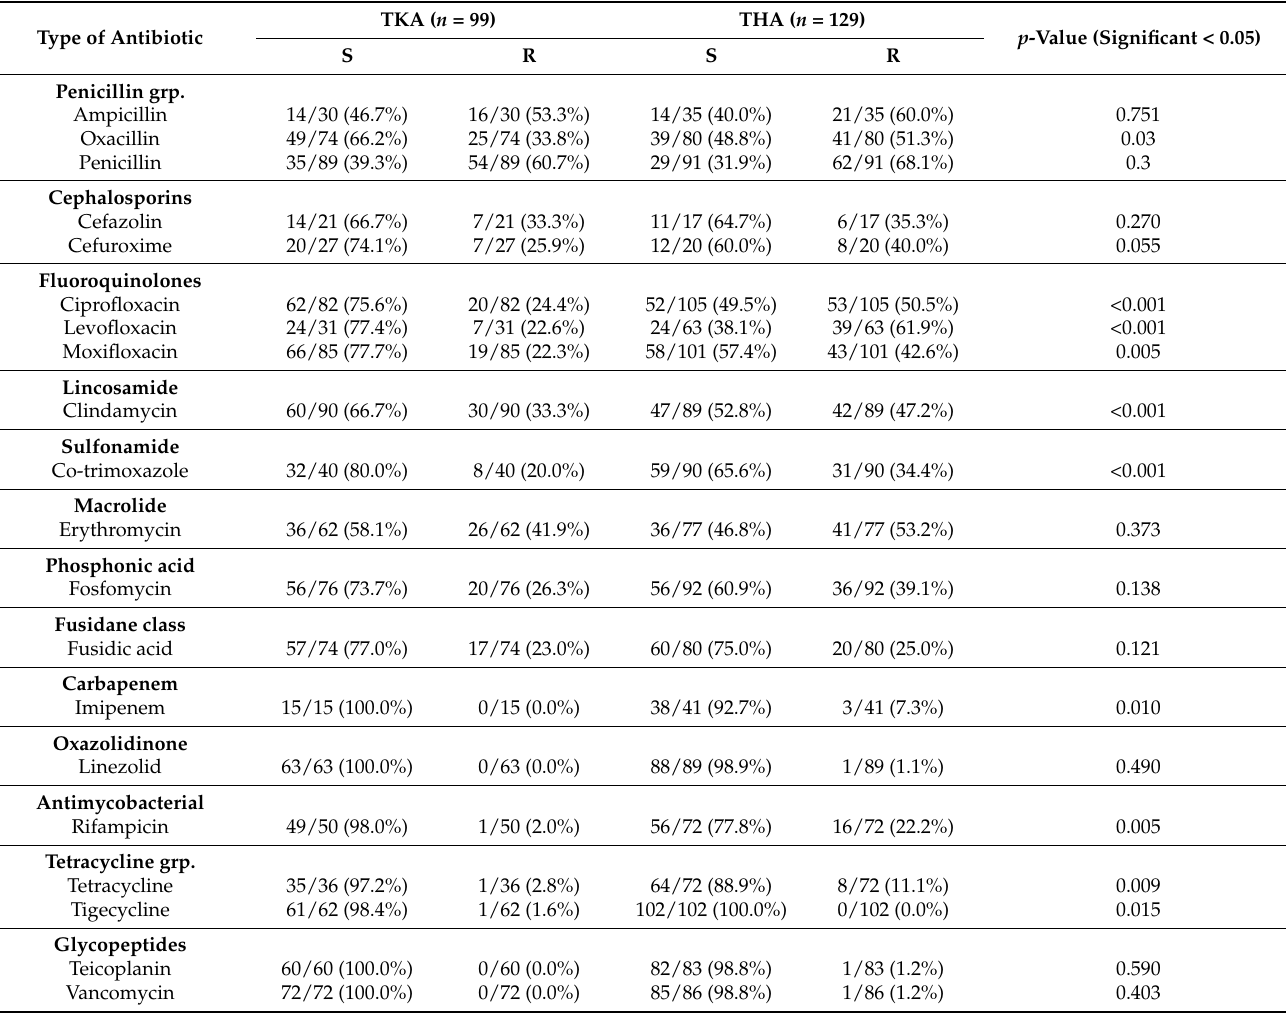
Table 2. Antibiotic resistance of 20 different types of antibiotics and its statistical significance, comparing revision TKA and revision